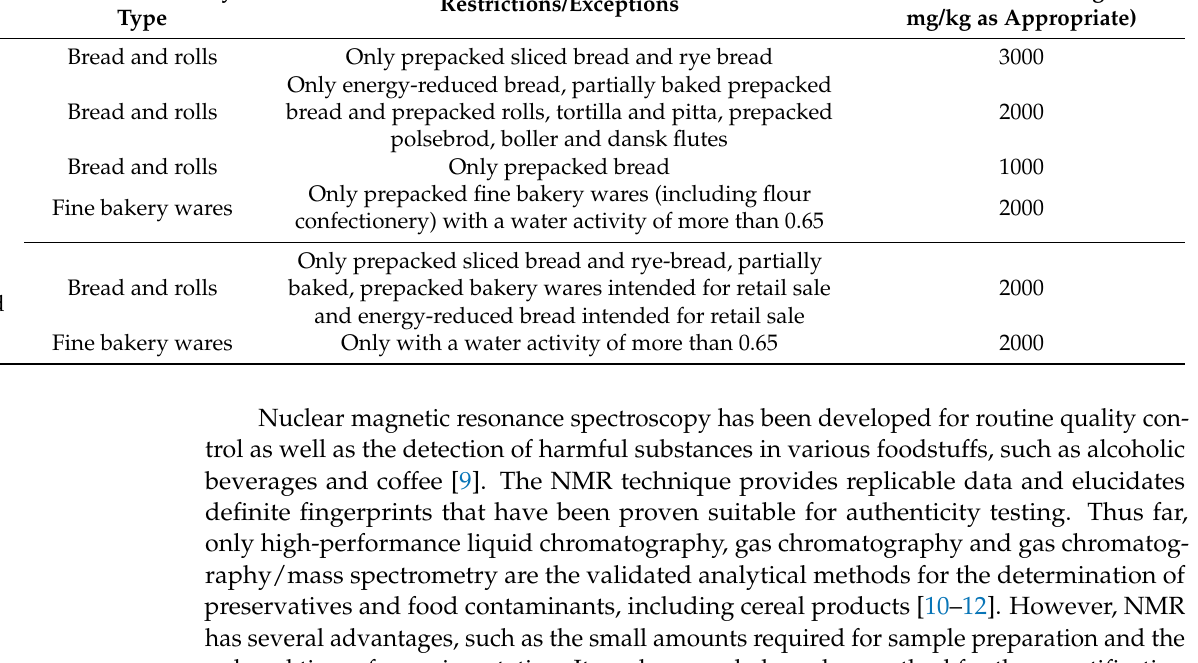
Table 1. Maximum permitted levels (MPLs) of propionic acid/propionates (E 280–283) and sorbic acid/sorbates (E 200–202) in bread and bakery products according to the Annex II of Regulation (EC) No 1333/2008—levels are expressed as free acid [4]. Bread and Bakery